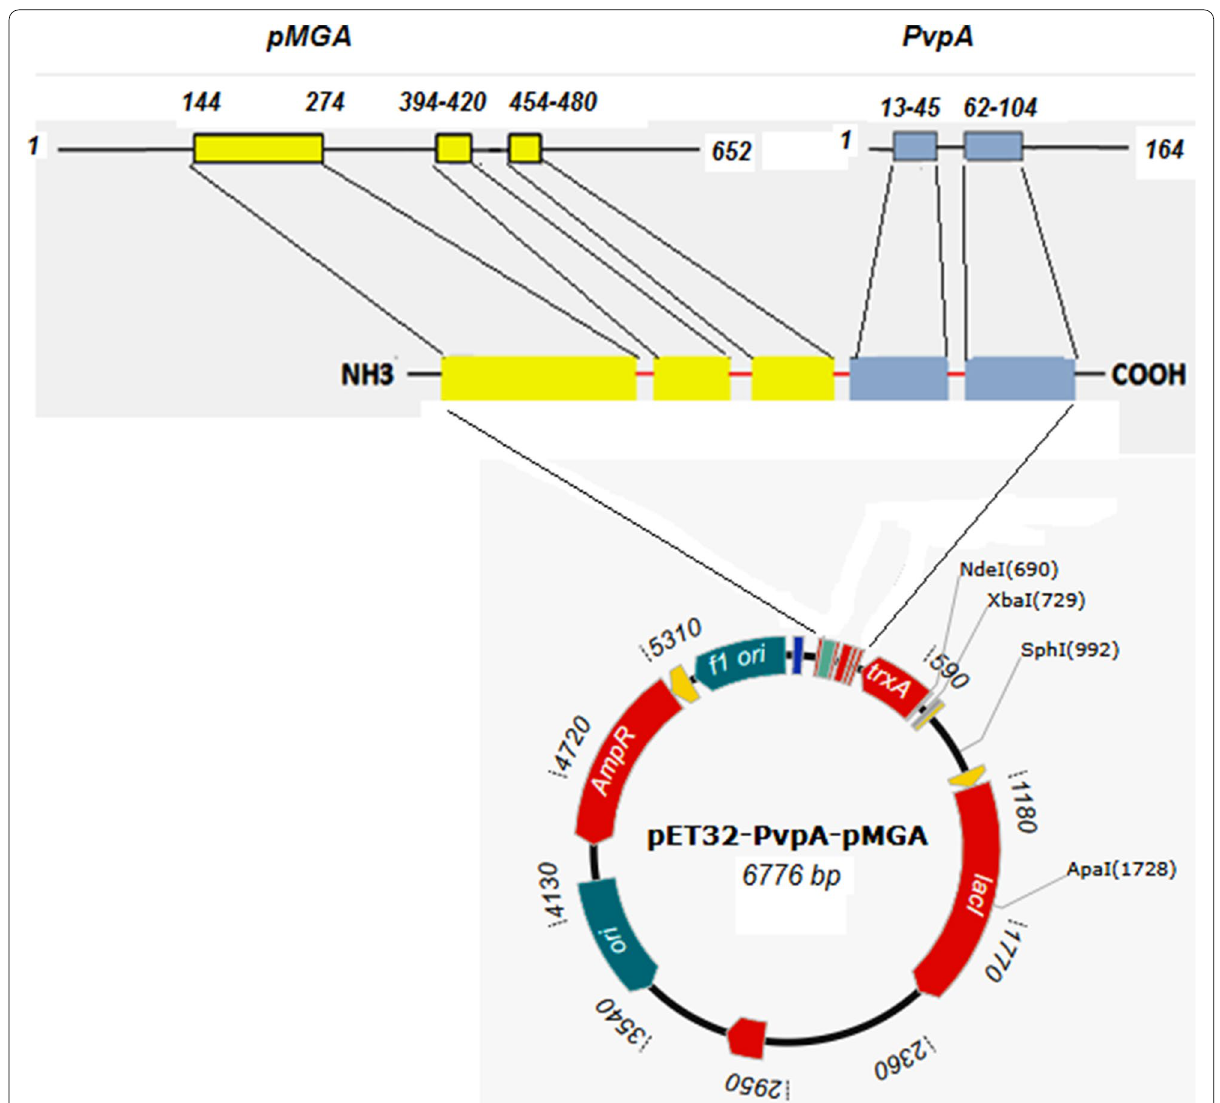
Fig. 2 Schematic diagram of the designed chimeric PvpA-pMGA protein and expression vector. Five amino acids (ggggs) were considered between five antigenic peptides as a